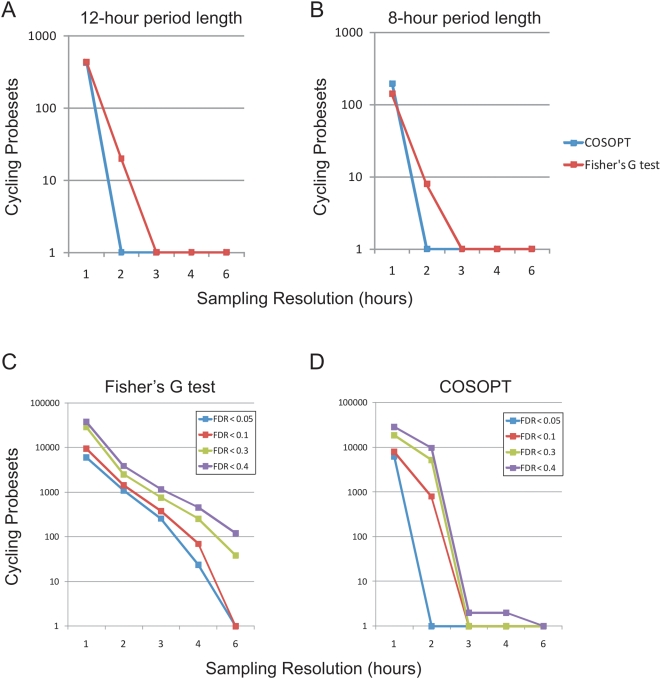
High temporal resolution is required to detect 12 and 8 h rhythms.COSOPT and Fisher's G-test were performed on subsets of the microarray data set to simulate the statistical power of sampling at a 1, 2, 3, 4 or 6 h resolution. The number of rhythmic genes detected at a FDR of <0.05 by either algorithm is plotted against the sampling resolution for 12 h (period >10 and <14) (A) or 8 h genes (period >7 and <9) (B). In each case, one hour sampling resolution is required to optimally detect transcriptional rhythms. Additional simulations revealed that both Fisher's G test (C) and COSOPT (D) detected considerably more rhythmic transcripts of all period lengths when samples were taken at a two-hour resolution or better. At very high FDRs (e.g. <0.4), using single algorithms, a sizable proportion of the genome is found to cycle. This observation underscores the importance of using appropriately low FDRs as well as multiple algorithms to cross-validate cycling genes.